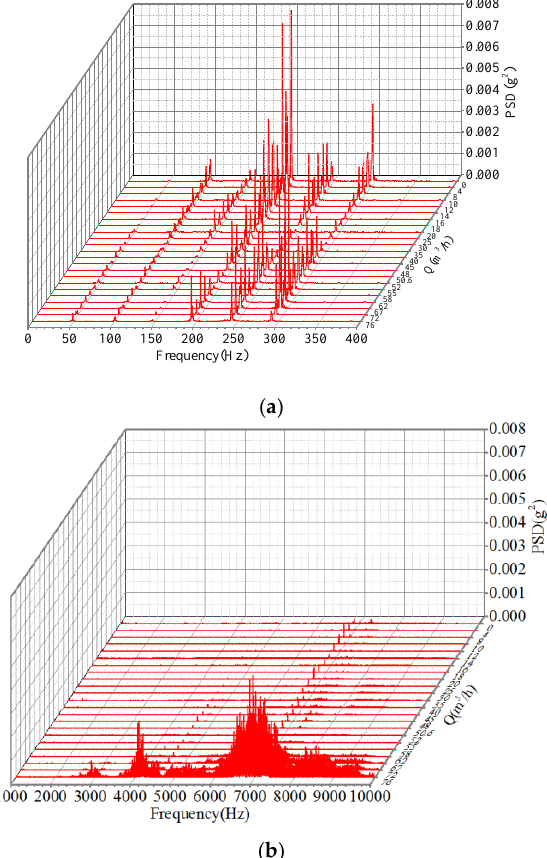
Figure 7. Power spectral density (PSD) of the vibration measured by accelerometer 1 under different flow rates. ( a ) 0 – 400 Hz, ( b ) 1 – 10 kHz.